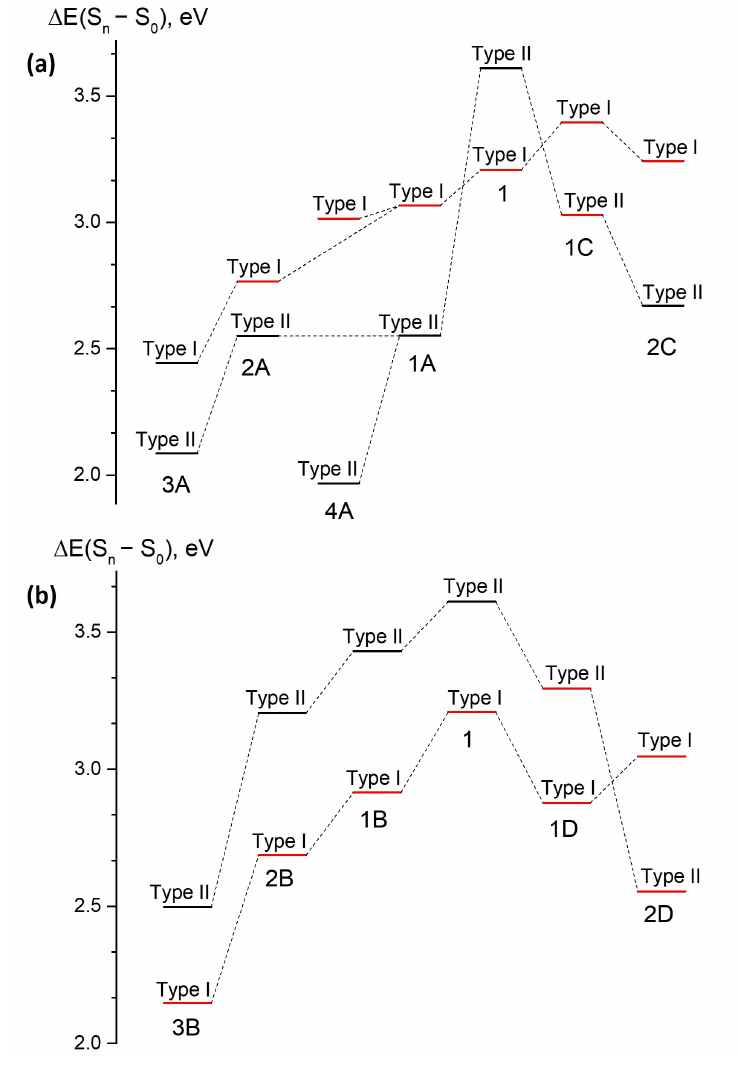
Figure 4. XMCQDPT2 vertical excitation energies for type I and type II transitions in the annulated locked GFP chromopore derivatives obtained through symmetric ( a ) and asymmetric ( b ) modes of annulation. Transitions with relatively high and low oscillator strengths are highlighted in red and black,